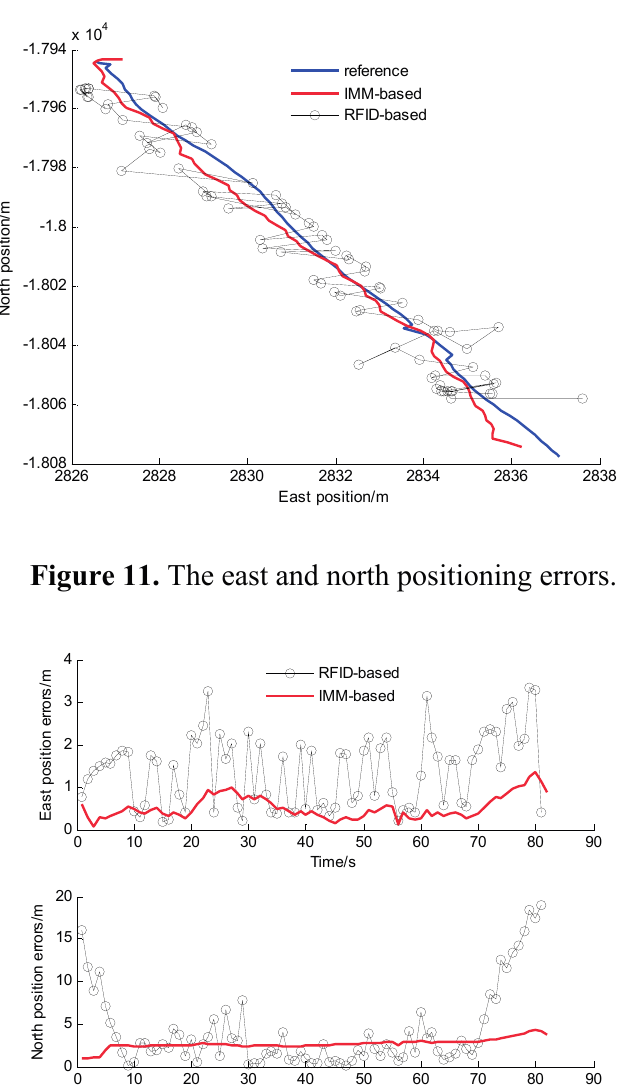
Figure 10. The vehicle trajectories.